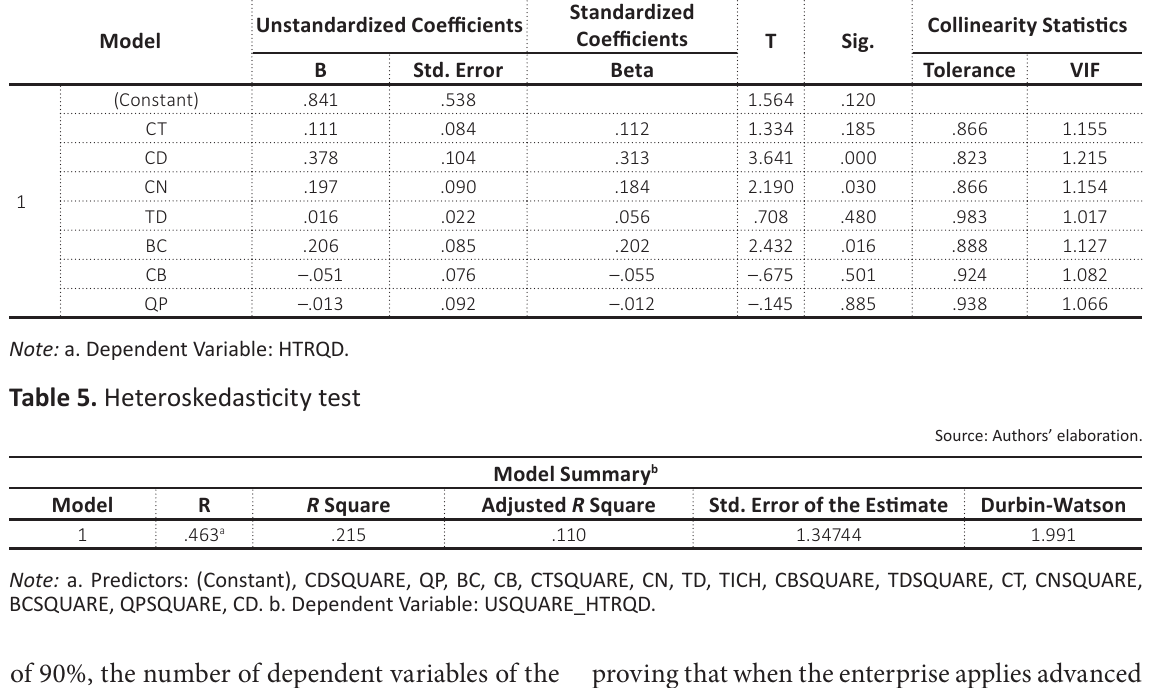
Table 4. Multicollinearity test